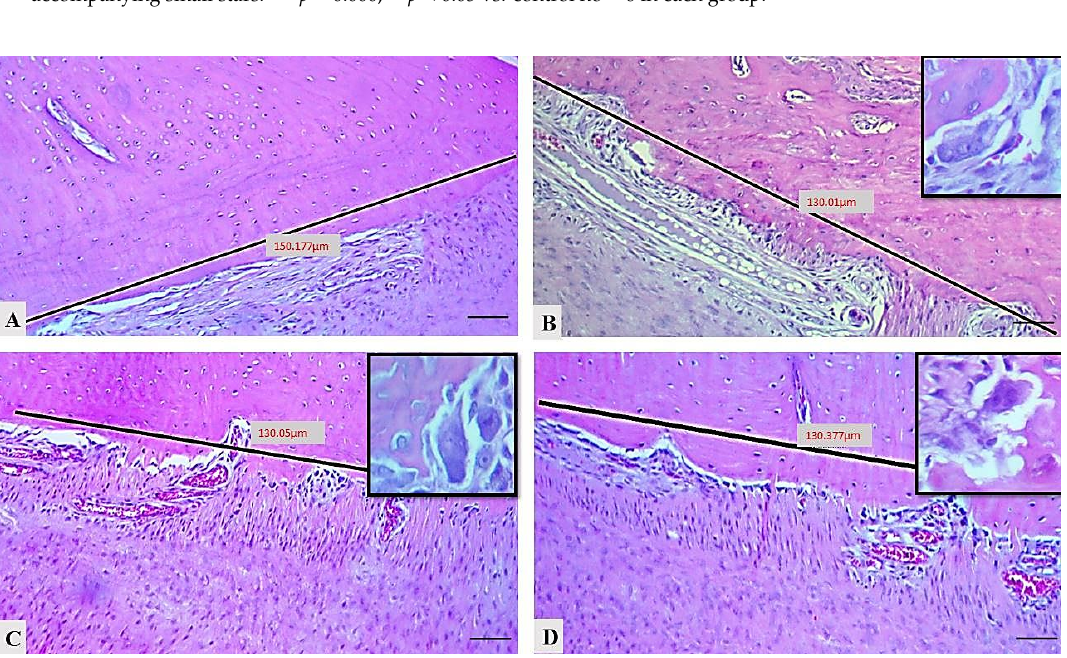
Table 4. Mean values for osteoclast cells, alveolar bone loss, level of IL1 β and RANK expression in each group in the study.